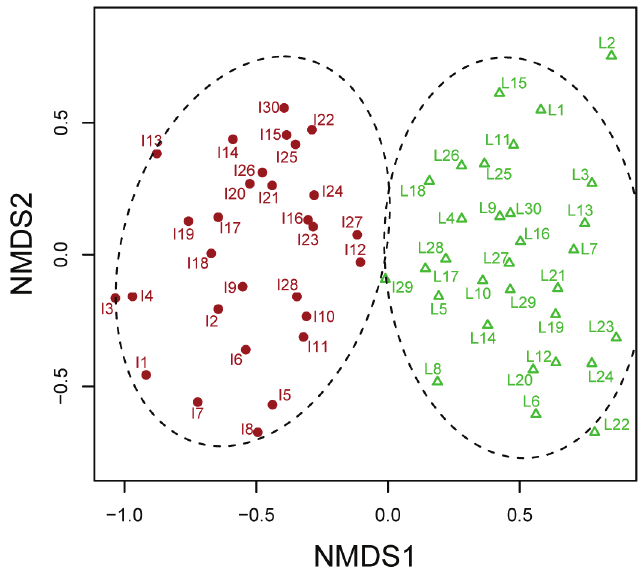
Figure 5. Non-metric multidimensional scaling ordination of each plot of the island and lakeshore sites. From I1 to I30: plots at the island site; from L1 to L30: plots at the lakeshore site. The differences of color and symbol represent the result of